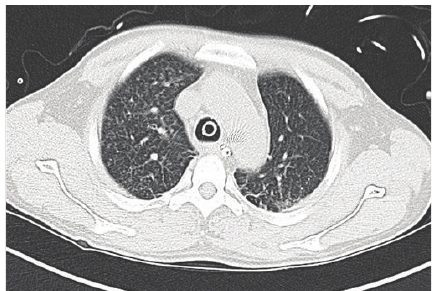
Figure 1: Chest CT scan showing numerous randomly distributed nodules bilaterally in upper lobe consistent with miliary pattern of distribution.